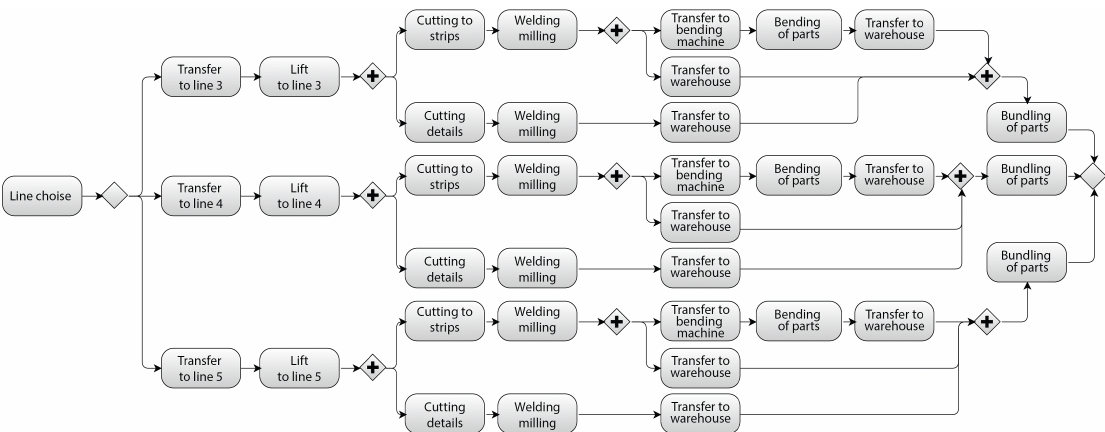
Figure 3. Fragment of the manufacturing process in BPMN.